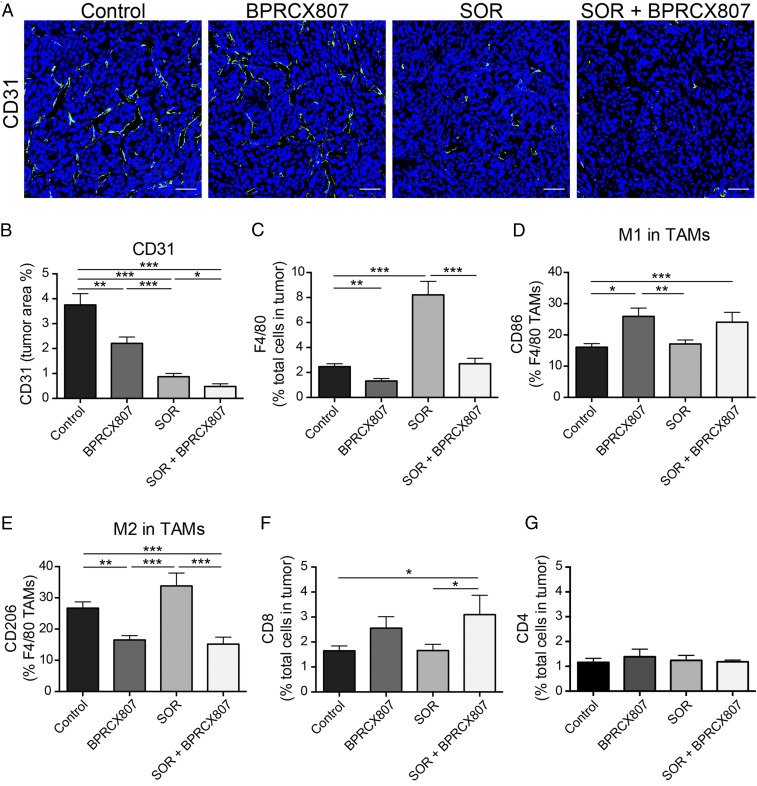
BPRCX807 inhibits angiogenesis and remodels the immunosuppressive tumor microenvironment in the orthotopic HCA-1 model. (A) Representative immunofluorescence images of tumor vessels indicated by CD31+ staining; CD31+ endothelial cells were stained green and nuclei were stained blue using DAPI. (Scale bar, 50 μm.) (B) MVD determined by CD31+ staining and presented as the percentage of the total tumor area (n = 7 to 12). (C) CD45+F4/80+ TAMs. (D) M1-like TAMs stained by CD86. (E) M2-like TAMs stained by CD206. (F) cytotoxic CD8+ T cells and (G) helper CD4+ T cells were measured by flow cytometry (n = 9 to 17). The data are the mean value ± SEM *P < 0.05, **P < 0.01, and ***P < 0.001.